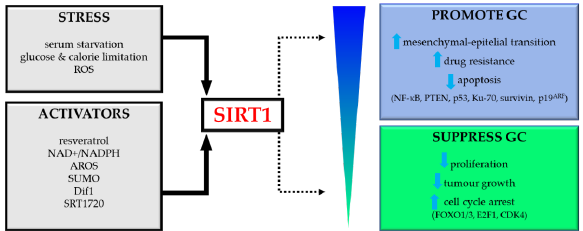
Figure 3. Dual role of SIRT1 in gastric cancer (GC). Abbreviations: ROS, reactive oxygen species; AROS, active regulator of SIRT1; SUMO, small ubiquitin-like modifier; PTEN, phosphatase and tensin homolog deleted on chromosome ten; CDK4, cyclin-dependent kinase 4.